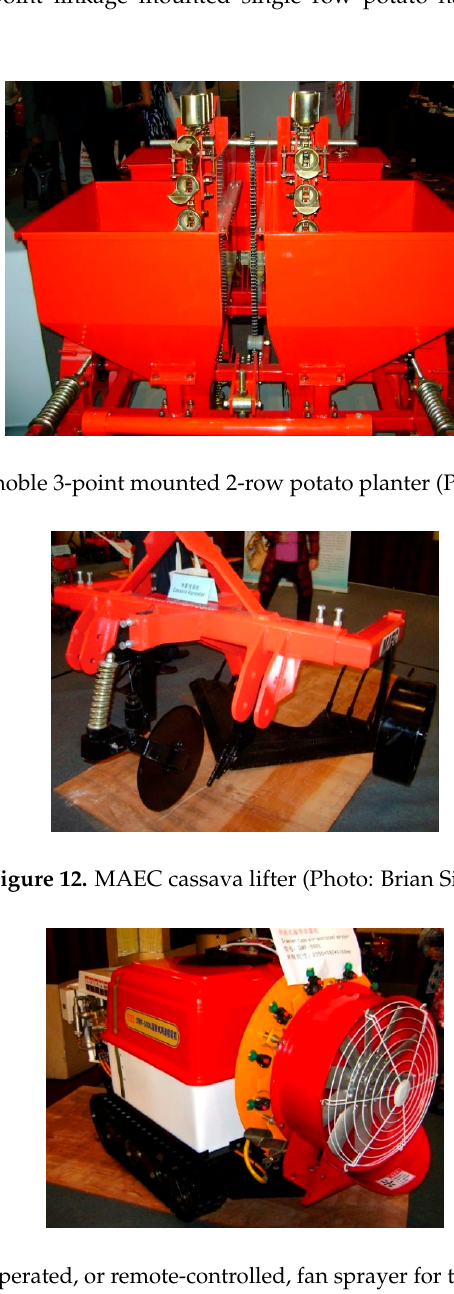
Figure 13. Datang hand-operated, or remote-controlled, fan sprayer for tree crops (Photo: Brian Sims).